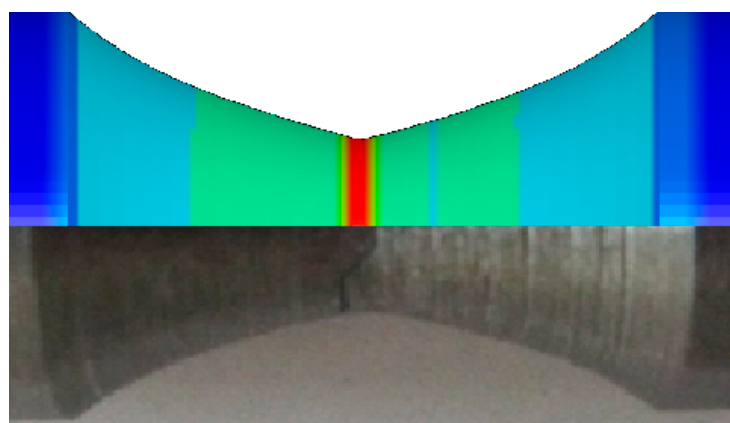
Figure 13. A comparison between the profiles of specimen measured from numerical simulation and quasi-static test.